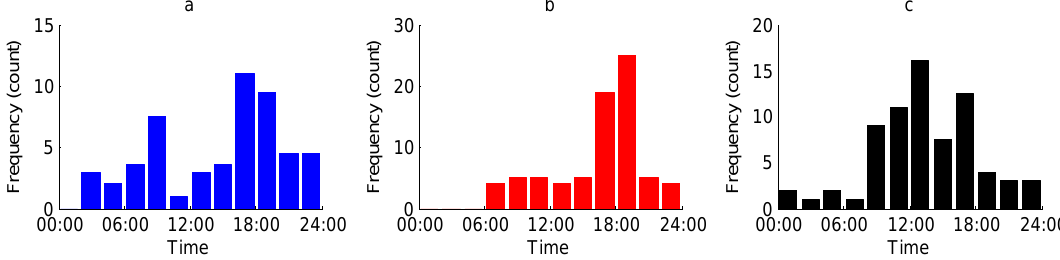
Fig. 2. Assignment of data to the three seasonal periods for the Central Aarhus (Central), Rundhøjskolen (Rundhøj) and TV-2 monitoring stations for each year. Contributing dates (i.e. dry days with daily average concentrations ≥ 20grainsm − 3 ) are in bold, and non-contributing dates for which period affiliation can be projected are faded.